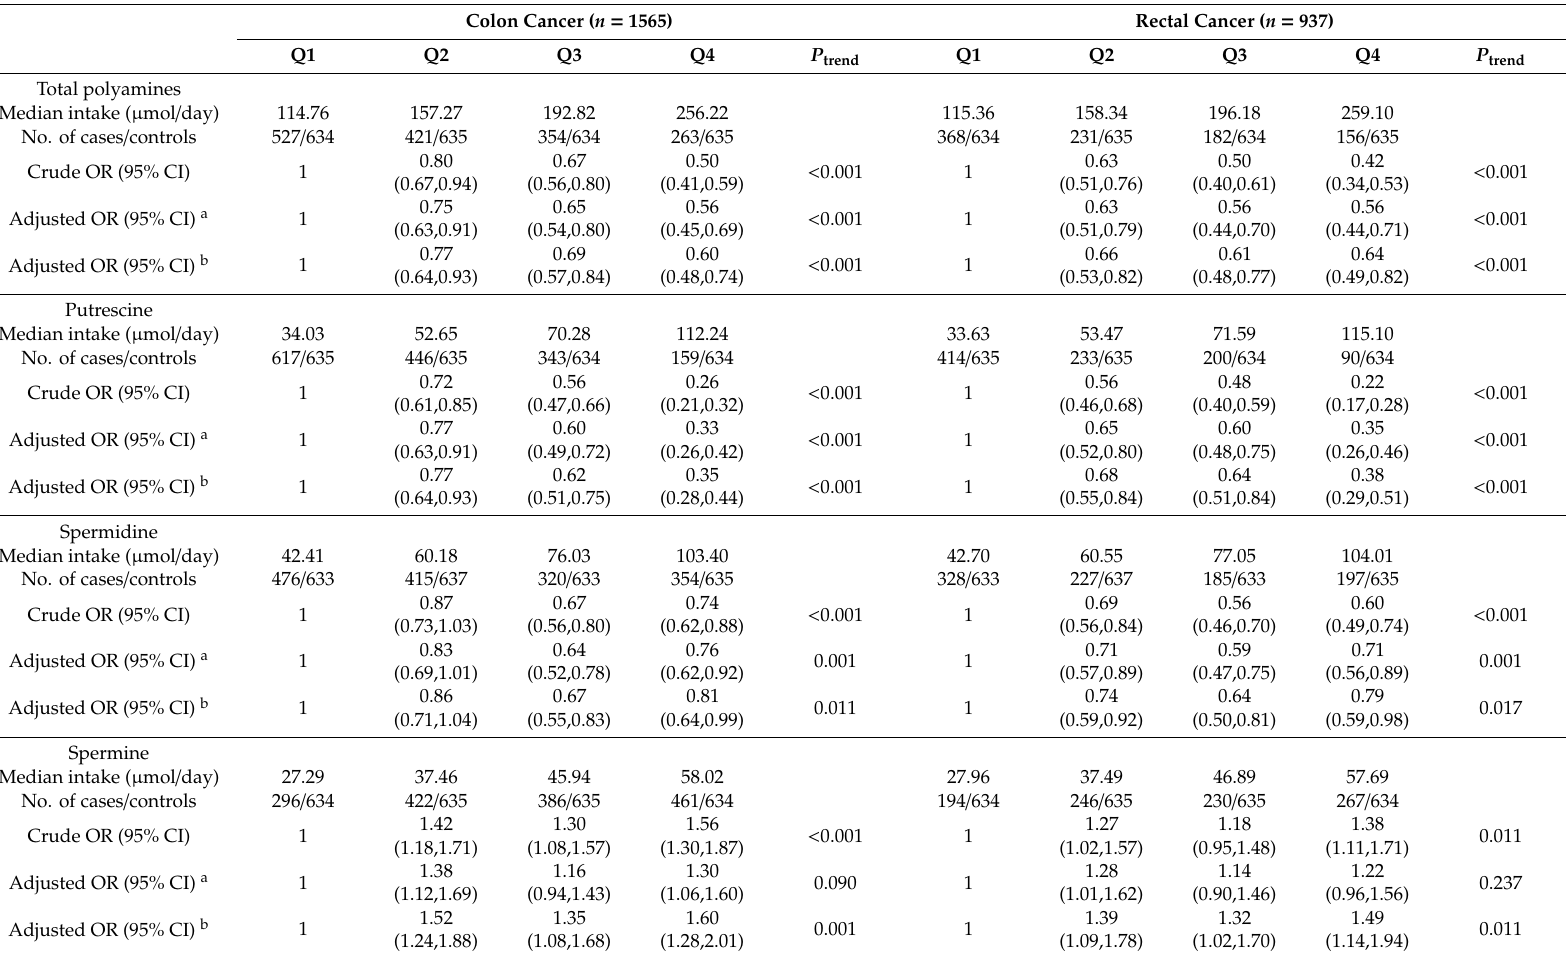
Table 5. Associations between polyamines intake and risk of colon and rectal cancers (Odds ratios and 95% confidence